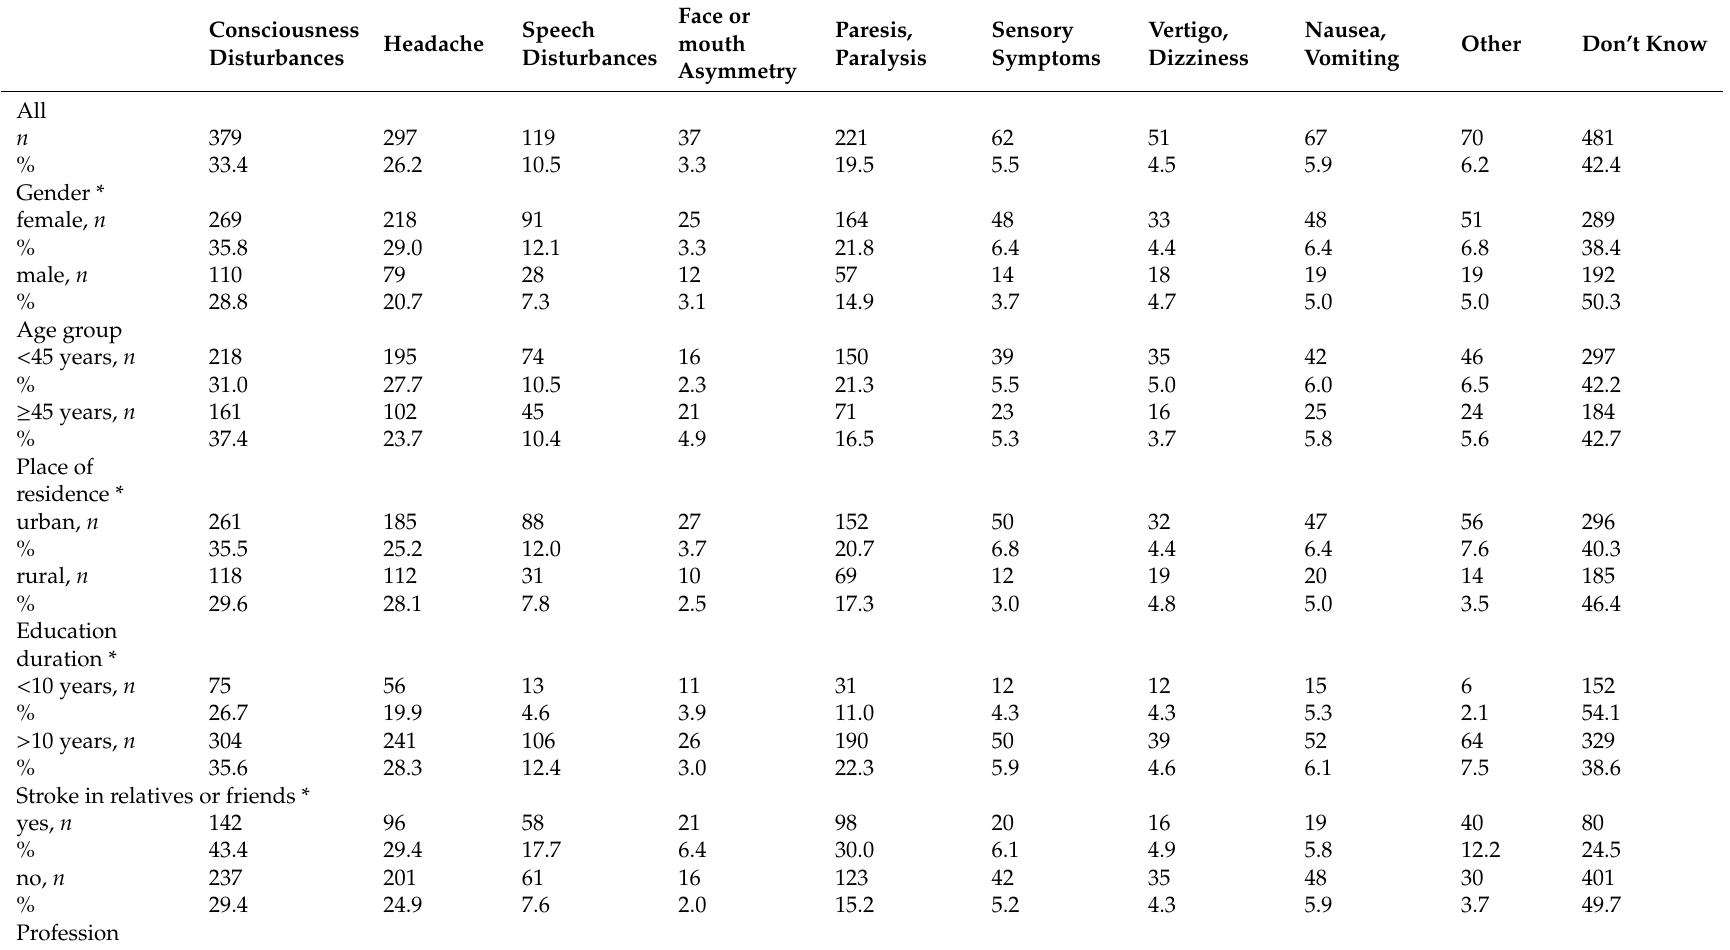
Table 4. Stroke symptoms provided by participants in response to an open-ended question grouped by gender, age group, place of residence, education level, and profession.